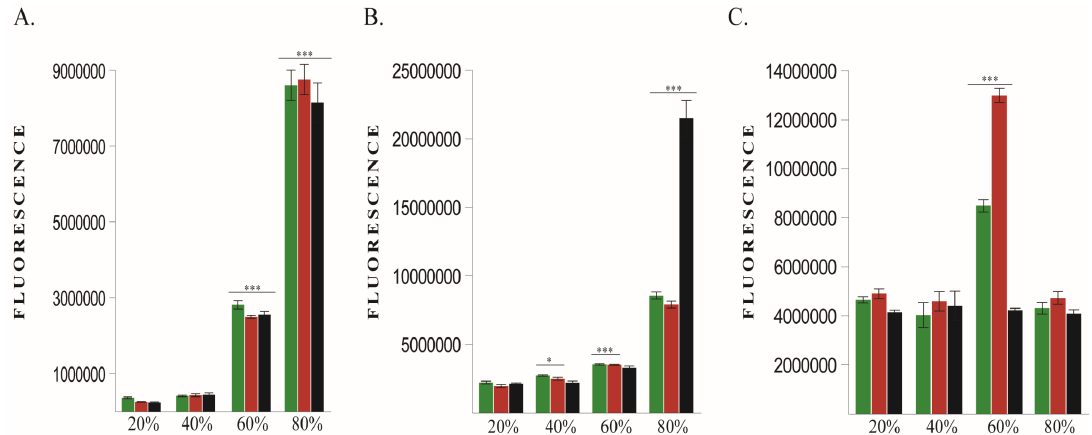
Figure 2. Reactive oxygen species (ROS) levels and cell viability. ( A ) ROS right after oxygen exposure; ( B ) ROS at 48h post oxygen exposure; ( C ) Cell viability. Green—MCF10A, Red—MDA-MB-231, Black—4T1. * p < 0.05, *** p < 0.0005.